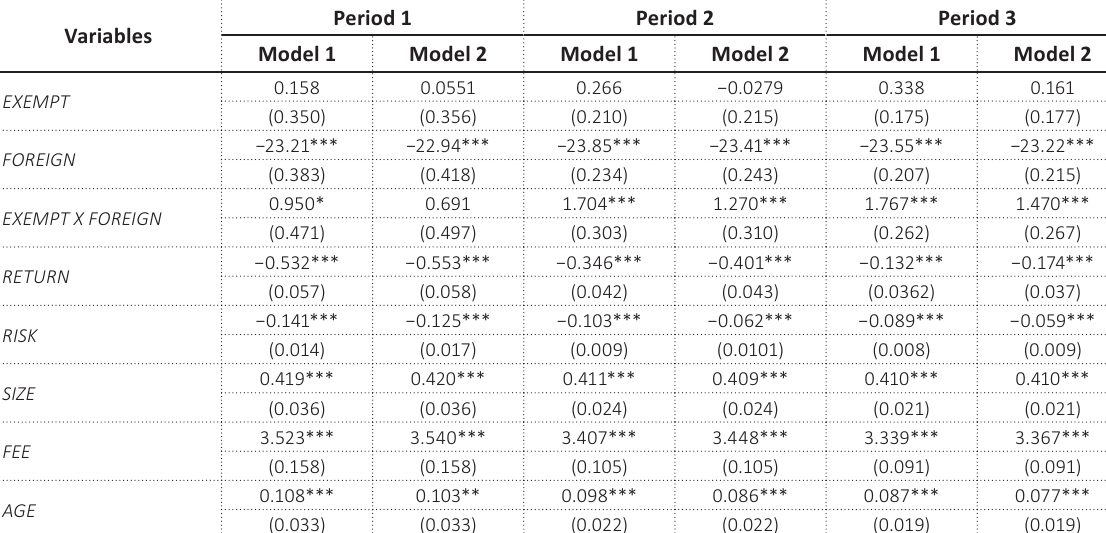
Table 7. Regression results: RSTA